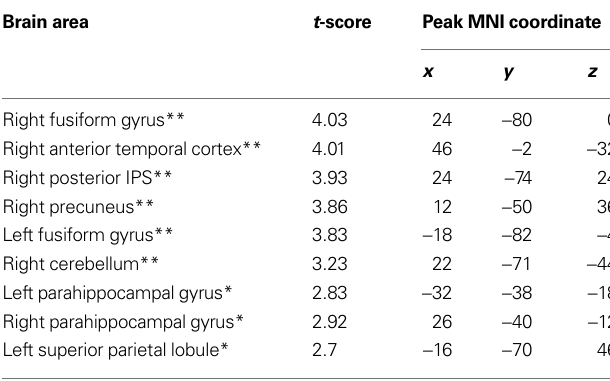
Table 3 | MNI coordinates of brain areas that showed signifi cant gray matter defi cits in children with